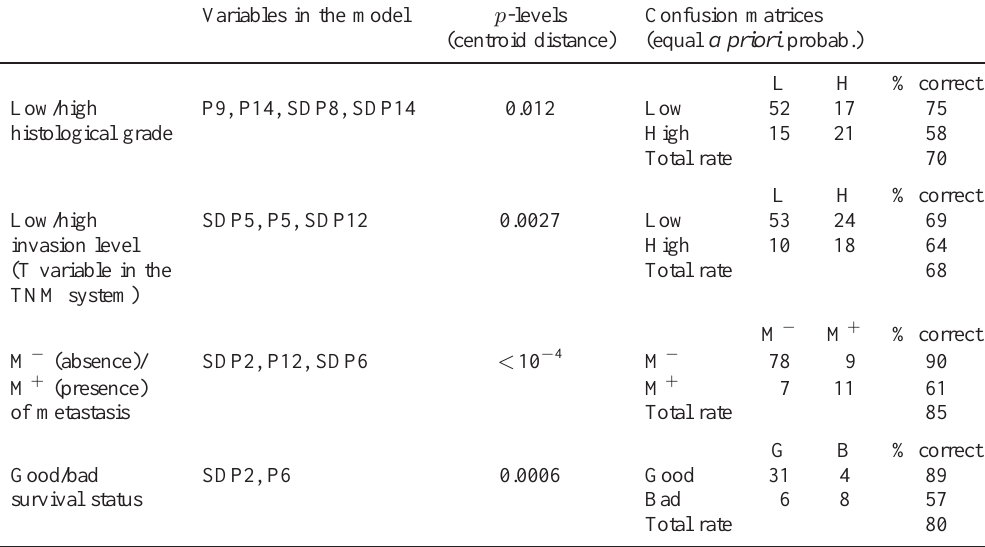
Table 2 Discriminant analysis performed on the few morphonuclear variables selected during the stepwise process Variables in the model p -levels Confusion matrices (centroid distance) (equal a priori probab.)